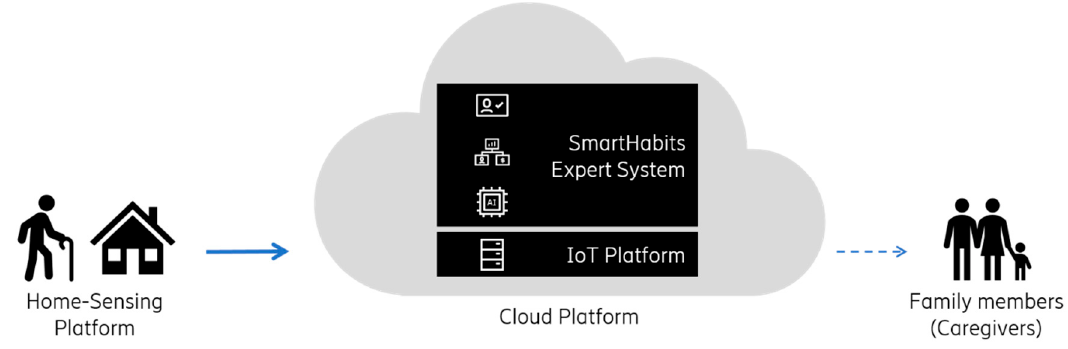
Figure 1. The SmartHabits system overview.